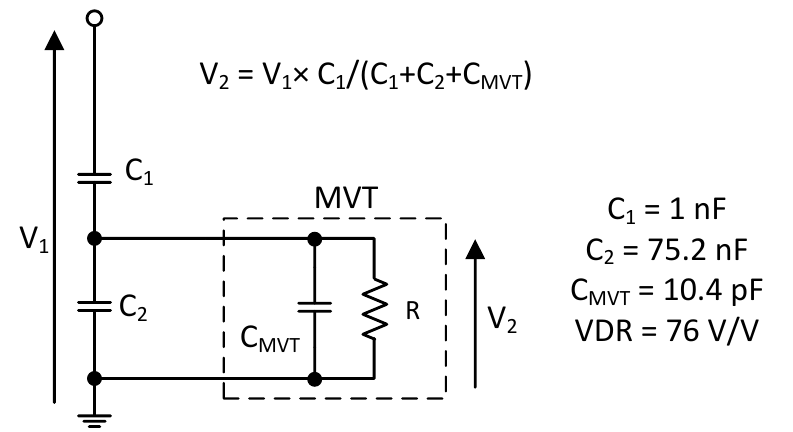
Figure 2. A diagram of the HV-to-MV voltage divider.